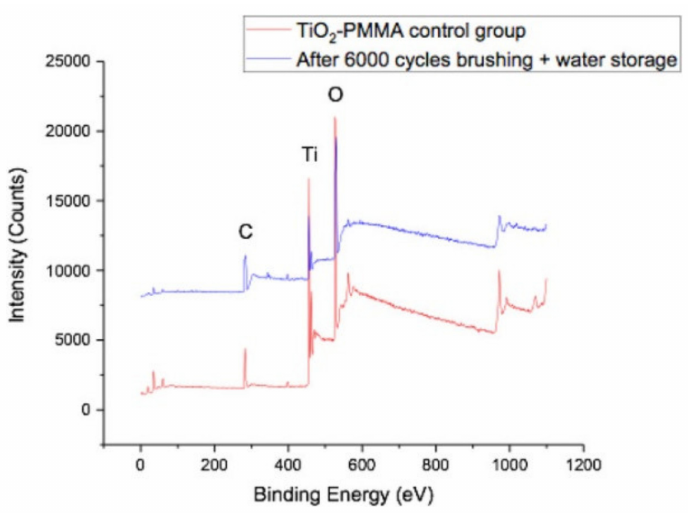
Figure 12. XPS results of coated PMMA unbrushed (red) and brushed (blue), storage in water and brushed again after 5 months [48]. PMMA has great mechanical properties and low toxicity for the dental prosthesis fabrication (this work by Ghaith Darwish is licensed under a Creative Commons Attribution (CC BY